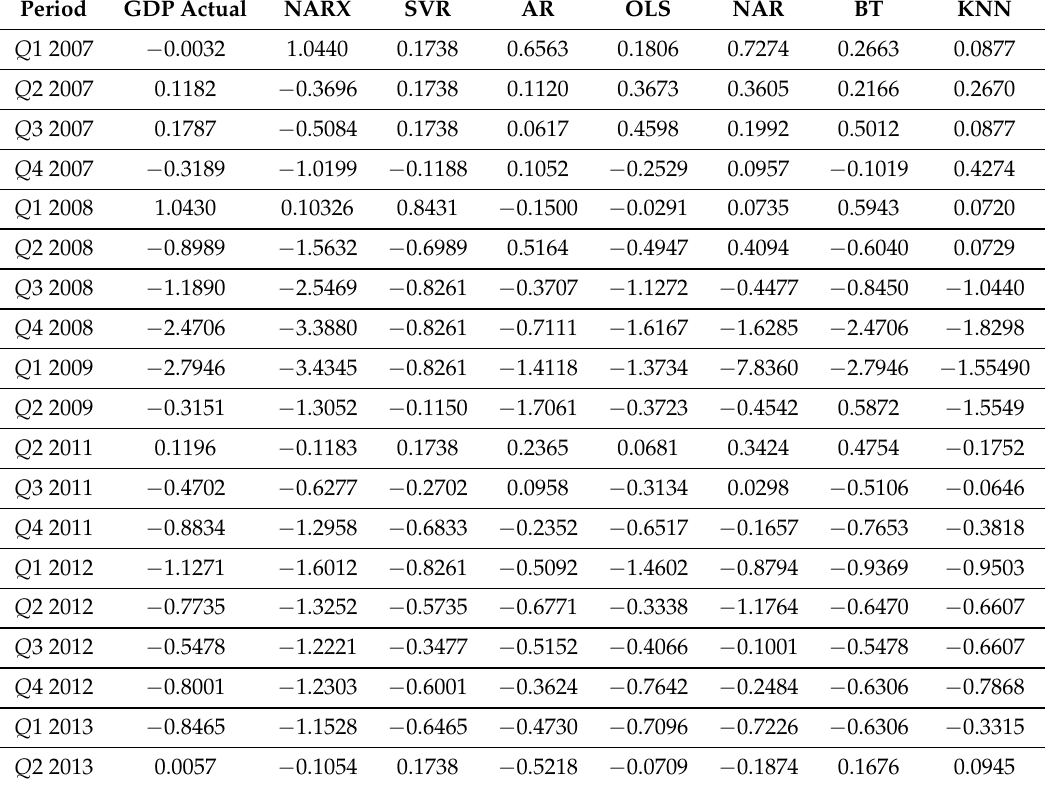
Table 2. Real GDP growth rate values published by OECD and fitting by all